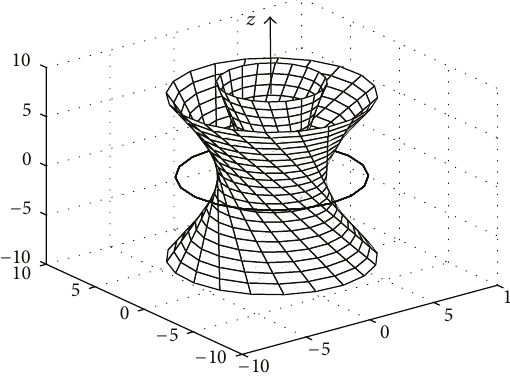
Figure 1: Twistor null lines of the Kerr congruence are focused on the Kerr singular ring, forming a two-sheeted spacetime branched by closed